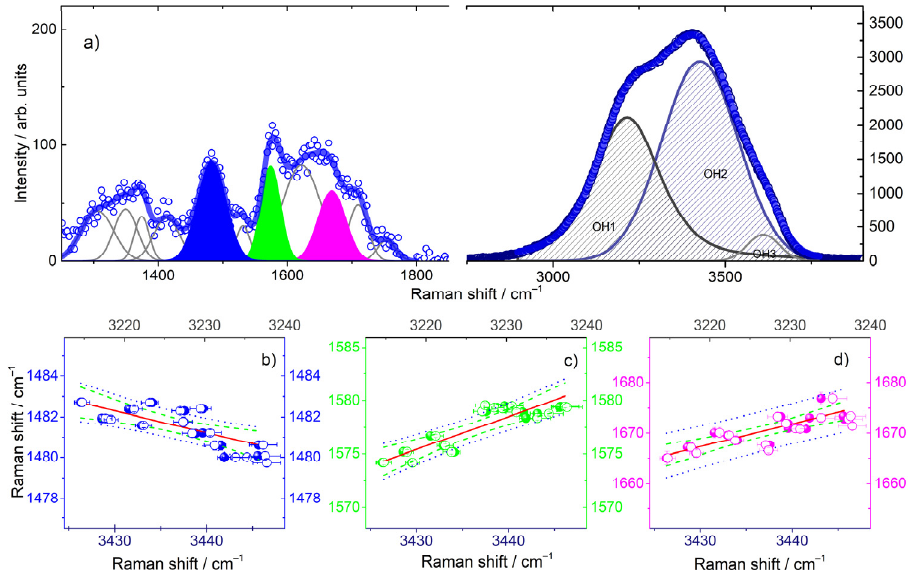
Figure 3. Panel ( a ) UVRR spectra of the Tel22 K+ water solution at 45 µ M at ambient temperature compared to the single and cumulative fitting curves. Panels ( b ) refer to the plot of ν 1482 vs. ν OH1 (left and bottom) and of ν 1482 vs. ν OH2 (right and top), panels ( c ) to the plot of ν 1575 vs. ν OH1 (left and bottom) and of ν 1575 vs. ν OH2 (right and top), and finally panels ( d ) to the plot of ν 1670 vs. ν OH1 (left and bottom) and of ν 1670 vs. ν OH2 (right and top). The red lines represent a fit to a straight line. The corresponding Pearson’s r values were − 0.75 and − 0.85 for data in the panel ( b ), 0.89 and 0.87 for the data in the panel ( c ), and 0.83 and 0.84 for the data in the panel ( d ); 95% confidence (green) and prediction (blue) bands are also shown for sake of completeness. The data set indicates a good correlation between G4 and OH vibrations.